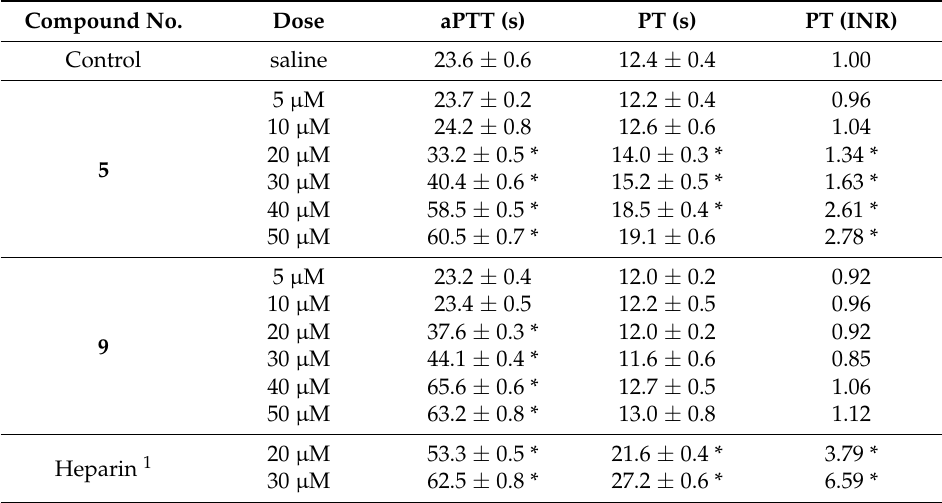
Table 2. In vitro anticoagulant activities of 5 and 9